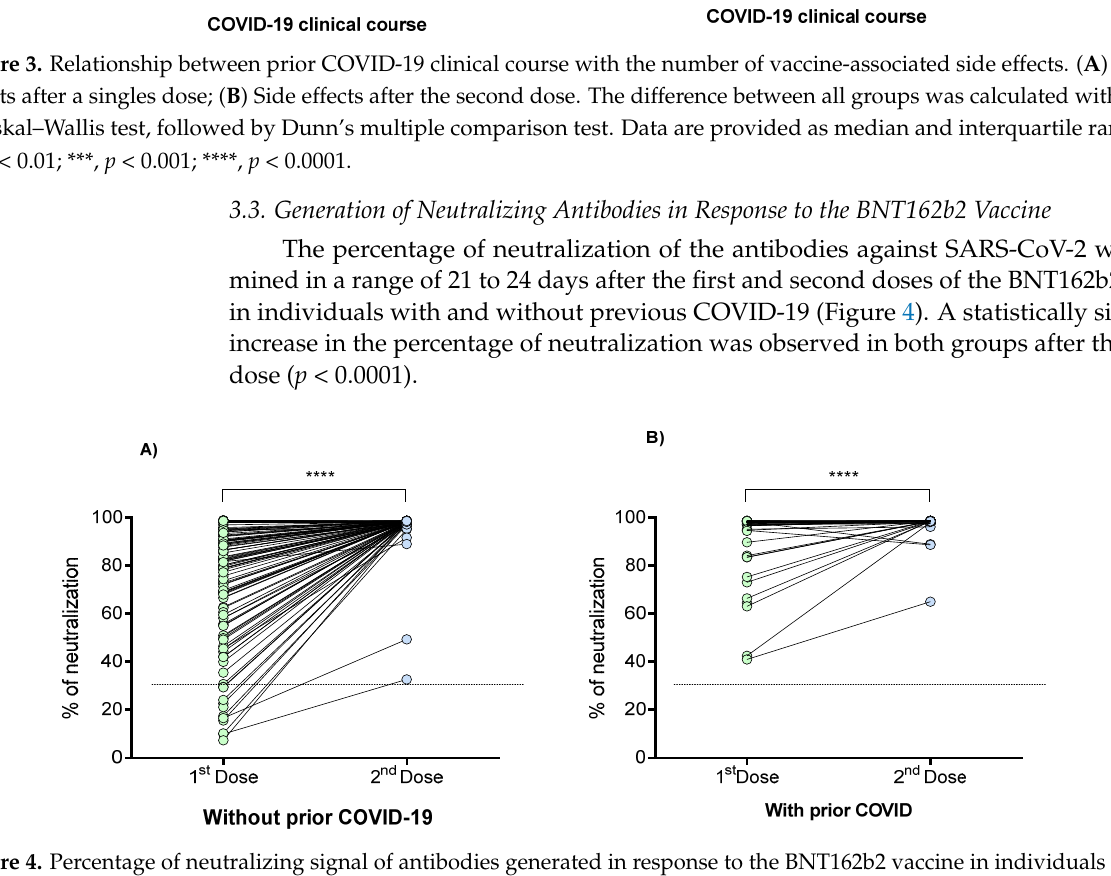
Figure 3. Relationship between prior COVID-19 clinical course with the number of vaccine-associated side effects. ( A ) Side effects after a singles dose; ( B ) Side effects after the second dose. The difference between all groups was calculated with the Kruskal–Wallis test, followed by Dunn’s multiple comparison test. Data are provided as median and interquartile ranges. **, p < 0.01; ***, p < 0.001; ****, p < 0.0001.